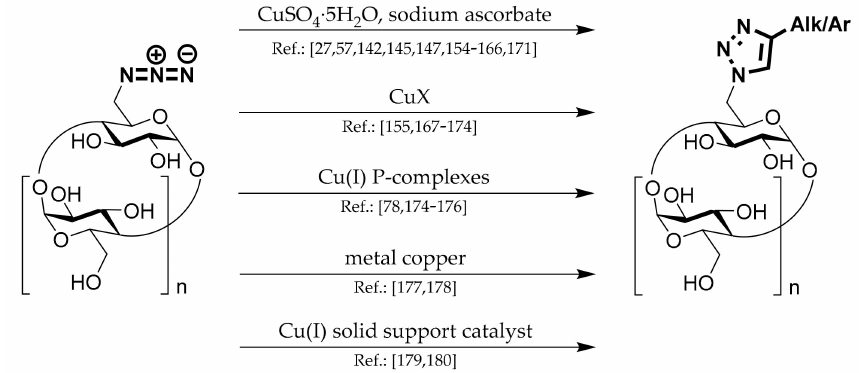
Ts-CDylation of NaN 3 in DMF Ts-CDylation of NaN 3 with KI in DMF Ts-CDylation of NaN 3 in DMF/water mixture